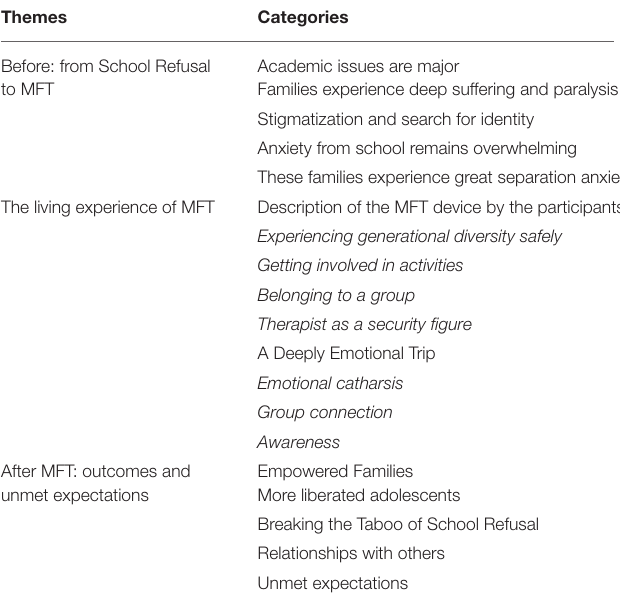
TABLE 4 | Summary of themes and